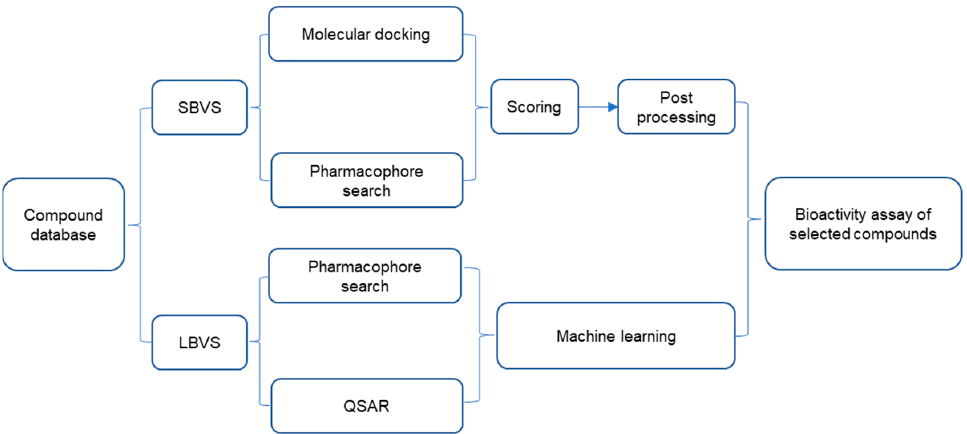
Figure 3. General flow chart of virtual screening. SBVS = structure-based virtual screening; LBVS = ligand-based virtual screening; QSAR = quantitative structure-activity relationship.